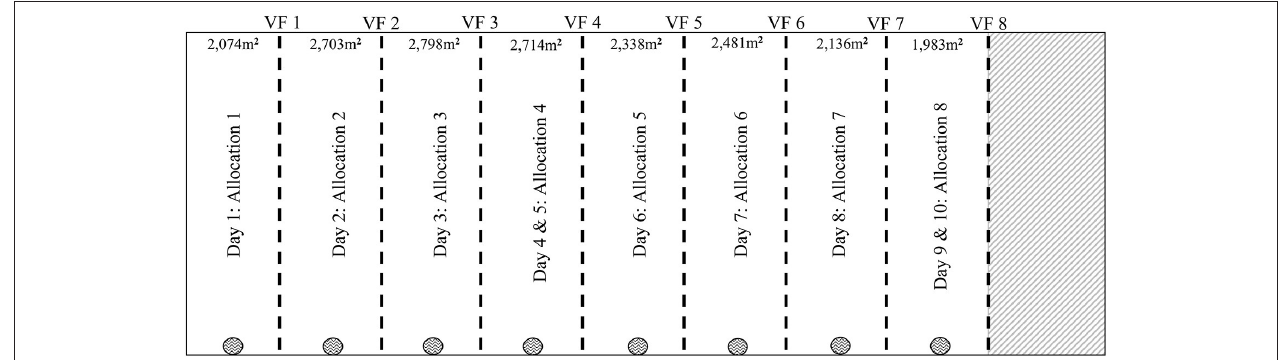
FIGURE 3 | Diagrammatic representation (figure not to scale) of the 1.2 ha paddock for the 10-day grazing period. The paddock was divided into eight pasture strips averaged at 2,324 ± 80.51 kg/DM/ha. Each day except for day 5 and 10 the VF was moved forward, and the cows were given access to a fresh strip of pasture. On day 5 and 10 the VF was not moved, and the cows were only able to graze on the previous day’s residual pasture. The area m 2 estimates based on the VF and backing fence for each allocation. The backing fences for each allocation is not presented in this figure. fixed fence; virtual fence; water